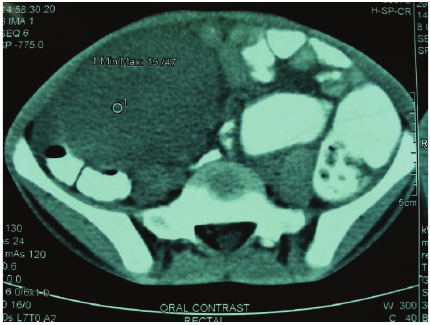
Figure1:CTpictureshowingawell-definedmassinrightiliacfossa.